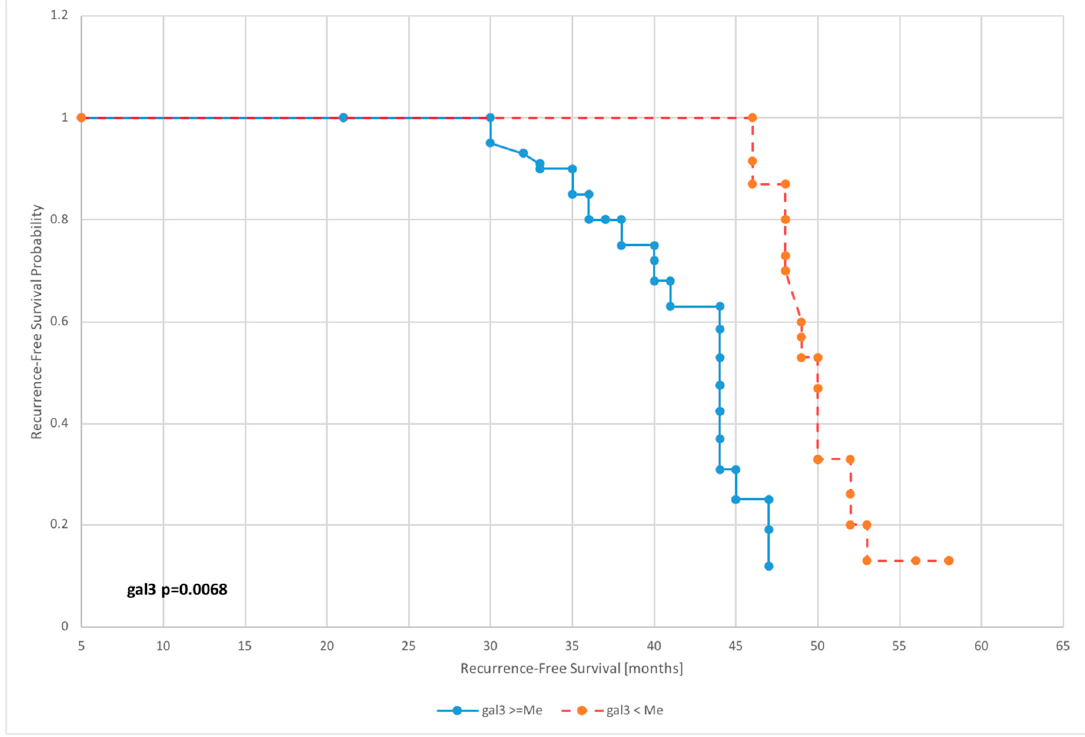
Figure 4. Kaplan–Meier recurrence-free survival curves for endometrial cancer patients based on serum galectin 3 level for median.